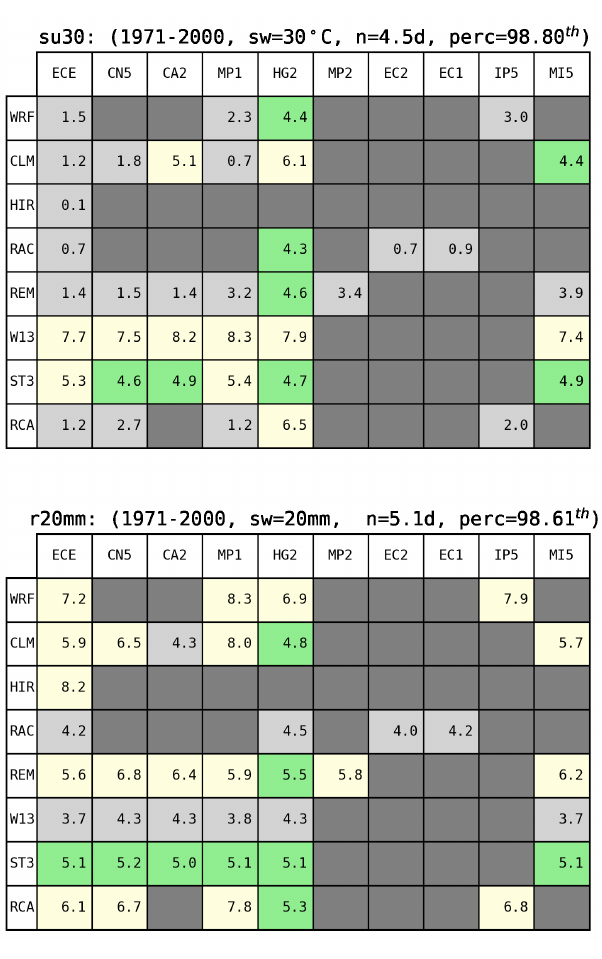
Table 3. Simulations of two threshold-based climate indicators (top: su30; bottom: r20mm) within the ReKliEs-De region and the period 1971–2000. Columns of every table – forcing global models. Lines of every table – RCMs or ESDs. Pairs of tables are displayed, left – simulated values, right – adjusted thresholds for the indicator. Light grey boxes – value is below the climatological average. Light yellow boxes – value is above the climatological average. Green boxes – average is met within a margin of 0 . 5 units (top left and bottom left: days, top right: ◦ C; bottom right: mm). Numbers above each table denote the threshold value (sw), the frequency of occurrence in days ( n ) and the percentile of the threshold (perc) computed from climate